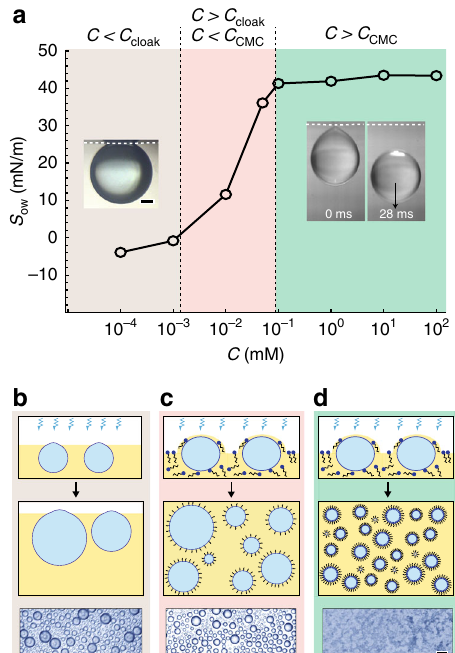
Fig. 2 Mechanism of emulsion formation via cloaking. a Plot of spreading coef fi cient as a function of surfactant concentration ( C ) in oil. At low concentrations (brown region: C < C cloak ), oil does not cloak water. Inset picture in this regime shows a water droplet balanced at a dodecane/air interface, suspended from the surface tension forces in a non-cloaked state. At high concentrations (green region: C > C CMC ), oil spreads over water and the surfactant stabilizes the emulsions. Inset picture in this regime shows a water drop falling from an interface where the oil phase (dodecane with 1mM Span 80) cloaks the water. At intermediate concentrations (pink region: C cloak < C < C CMC ), the oil phase cloaks water drops but the surfactant inadequately stabilizes emulsions, resulting in large polydisperse emulsions. Scale bar shows 500 μ m. b – d Schematics and microscopic images of the three corresponding regimes presented in part a . Part b shows low surfactant concentrations ( C < C cloak ), part c shows intermediate surfactant concentrations ( C cloak < C < C CMC ), and part d shows high surfactant concentrations ( C > C CMC ). Optical images show emulsions formed after 5min using 10 − 4 mM Span 80 (part b ), 10 − 2 mM Span 80 (part c ), and 1mM Span 80 (part d ) in dodecane. Scale bar represents 50 μ